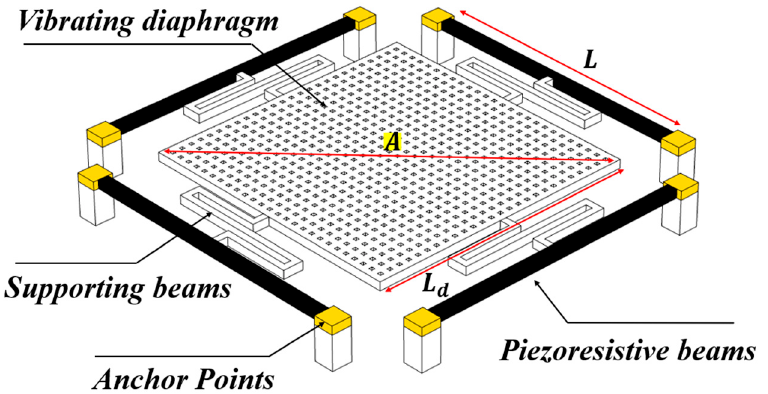
Figure 1. The structure of the sensor.